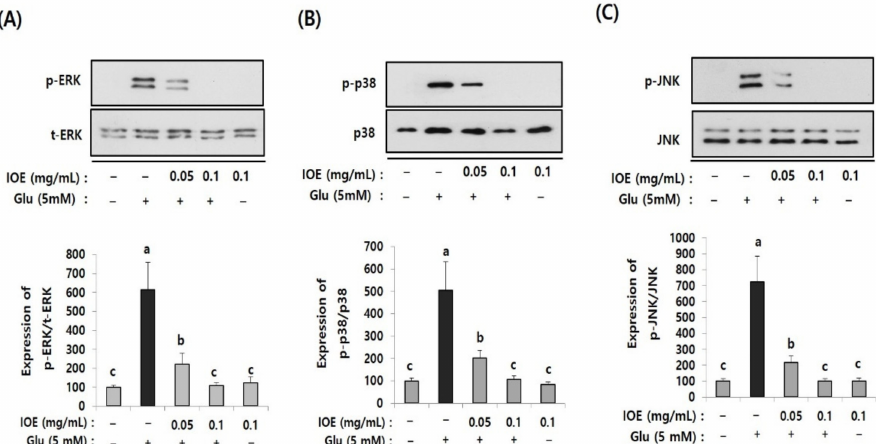
Figure 9. The glutamate-induced dysregulation of MAPKs was reversed by IOE. HT22 cells were pretreated with IOE for 2 h with and without glutamate (5 mM), and the phosphorylation of ERK ( A ), p38 MAPK ( B ), and JNK ( C ) was measured by Western blotting ( n = 3). The density of each band was estimated by ImageJ program and the value of each band was calculated and tabulated. Each data value is expressed as the mean ± SD. Glu: Glutamate. Non-treated cells (IOE- and Glu-) were used for the control. Experiments were conducted in triplicate and repeated three times with similar results. a: significant differences ( p < 0.05) when compared with b or c; b: significant differences ( p < 0.05) when compared with a or